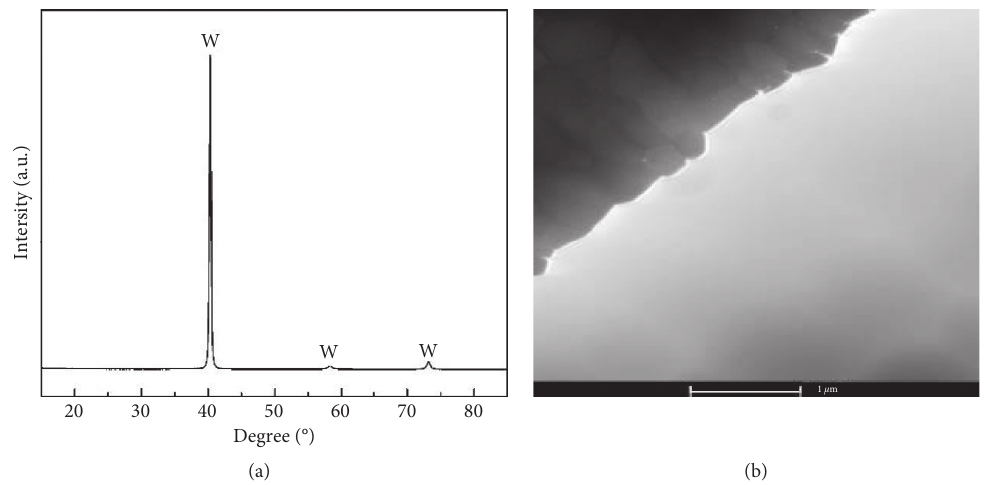
Figure 2: XRD (a) and TEM images (b) of high-density WF/Zr-MG composite.